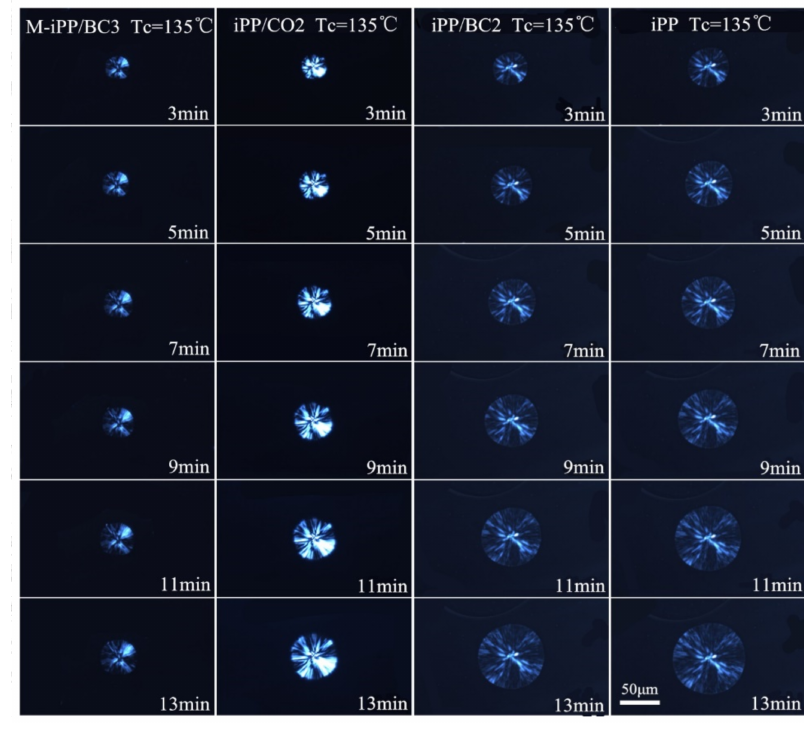
Figure 6. The POM images of the iPP/BC composites at 135 ◦ C.